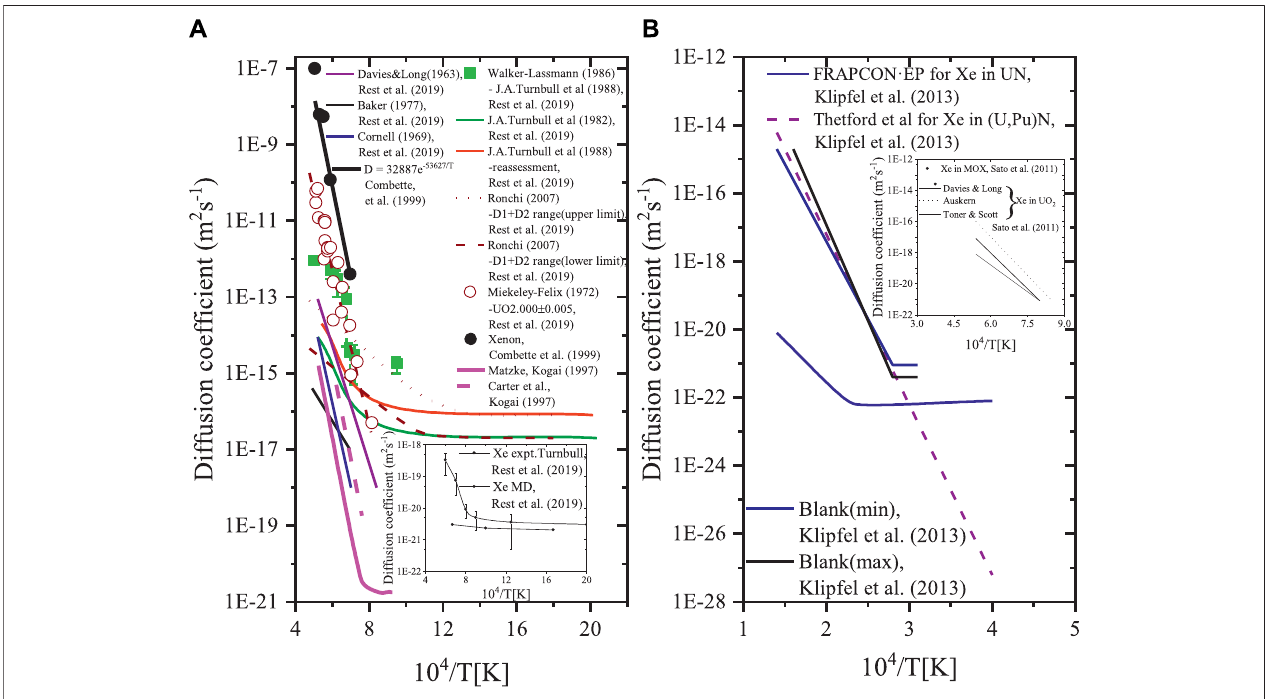
FIGURE 6 | Diffusion coef fi cient with temperature in the UO 2 , MOX and UN fuels (Kogai, 1997; Combette et al., 1999; Sato et al., 2011; Klipfel et al., 2013; Rest et al., 2019).